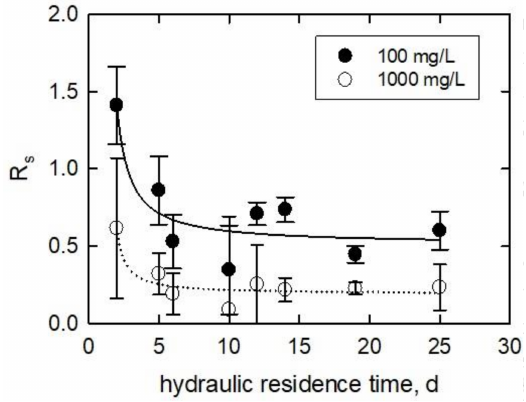
Figure 6. Normalized specific cell growth plotted against the hydraulic residence time of the continually stirred tank reactors in which the algae inoculums were cultured. Lines are fitted using Equation